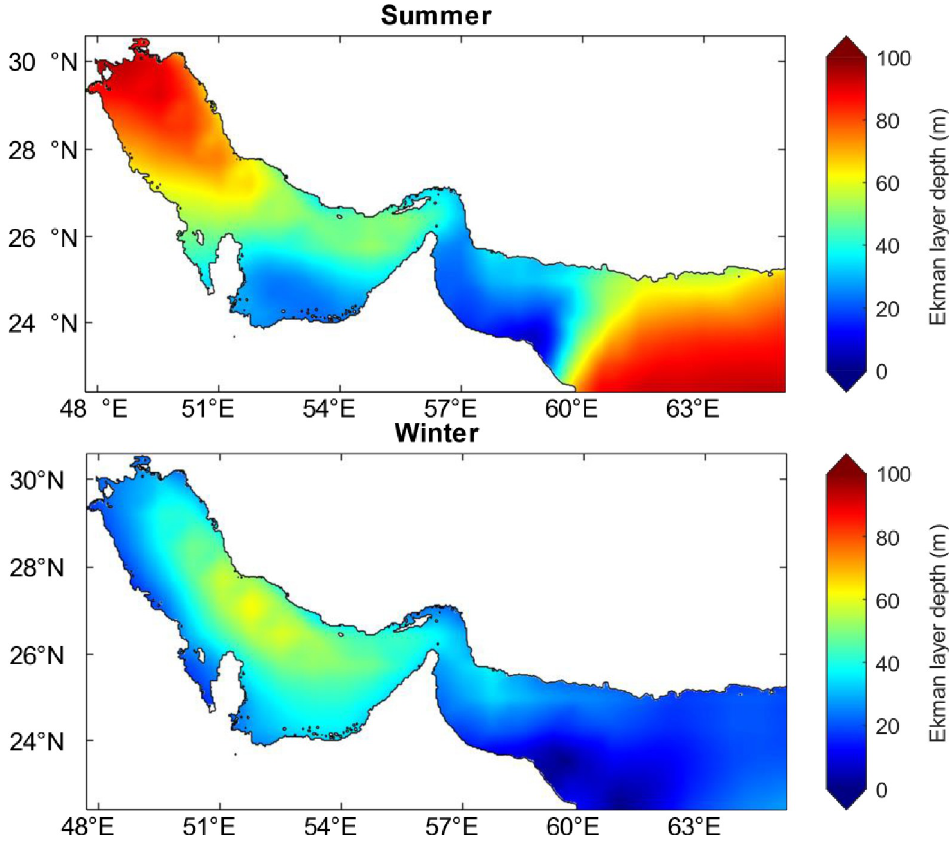
Fig 8. Seasonal Ekman layer depth (m) over the Arabian Gulf and Sea of Oman calculated from the wind speed which is extracted from the ECMWF (ERA5) datasets from the monthly climatology of the year 2018. ERA5 Climatologies have been calculated over the long-term average period of 1981–2010. Top: Summer season (June, July, August); bottom: Winter season (December, January,